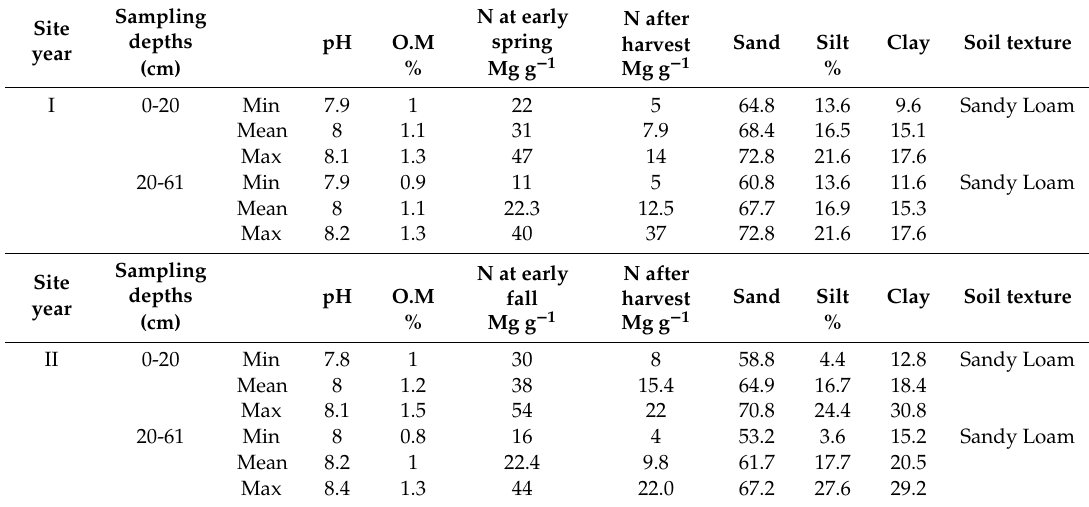
Table 1. Summary of soil properties for soil samples acquired at depths of 0–20 cm and 20–61 cm.